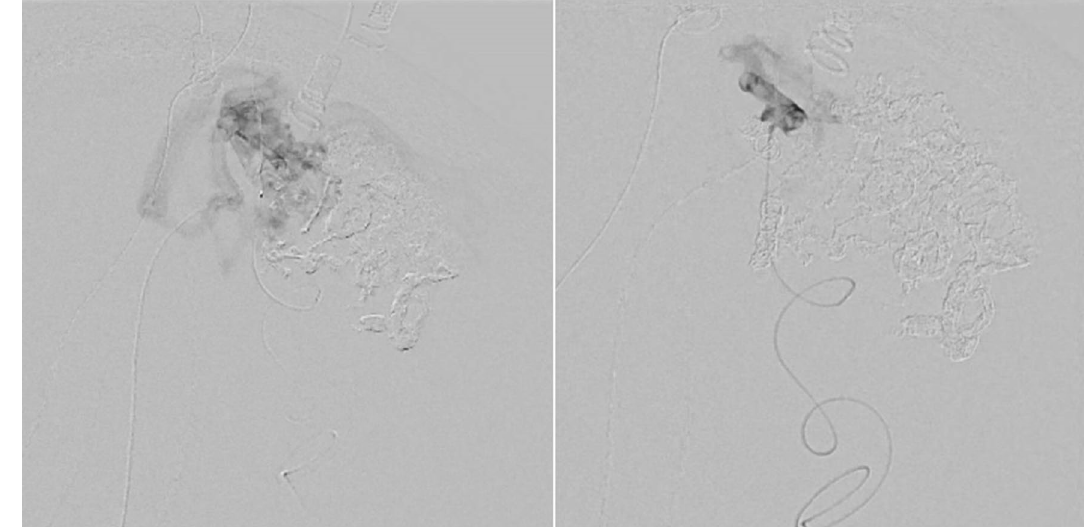
Fig. 9 DSA imaging. Microcatheter injection in MCA branch, a before and b after building a wedge of coils and glue in lateral view